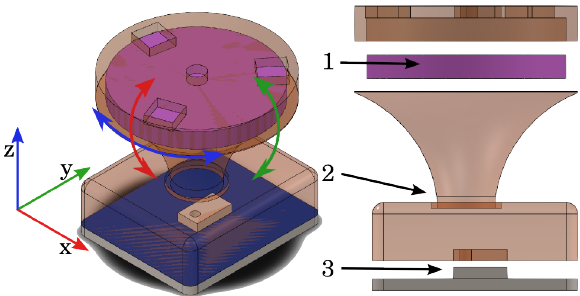
Figure 1. Components of the tactile sensing module: 1—MARG (magnetic, angular rate, and gravity) system; 2—compliant structure; 3—barometer